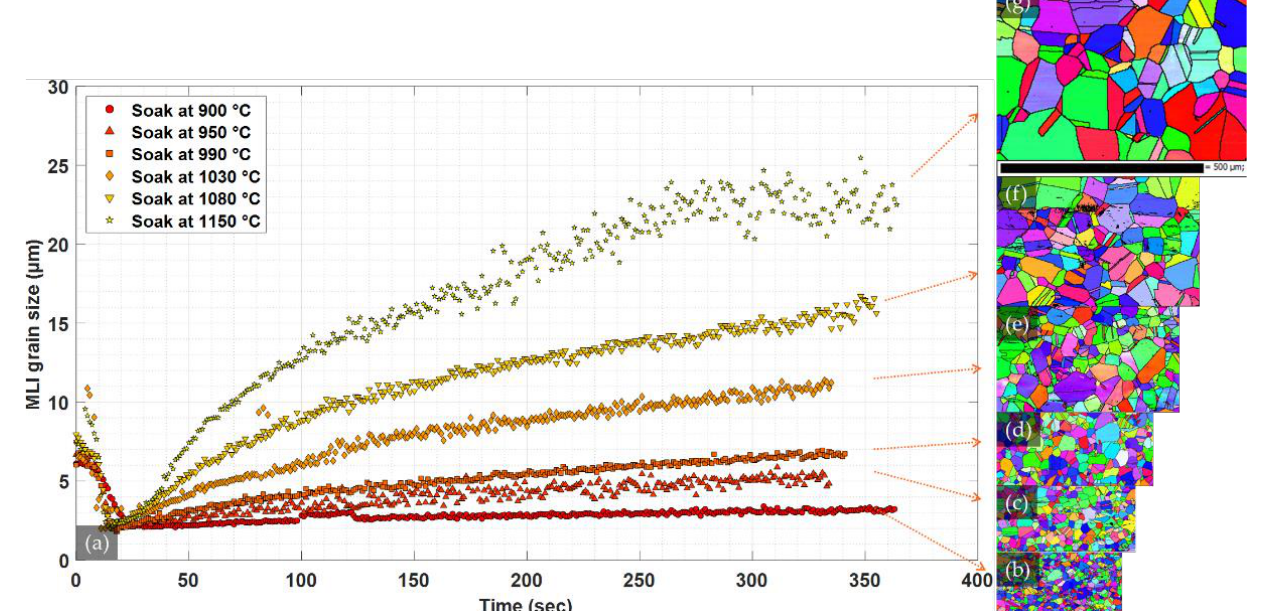
Figure 6. ( a ) Graph of the measured grain size as a function of time at the soaking temperature for six of the stainless steel samples. ( b – g ), EBSD inverse pole figure (IPF) maps of the samples post annealing at 900 – 1150 °C, respectively. The micrographs are, for pedagogic reasons, cropped and resized to share the same size scale.